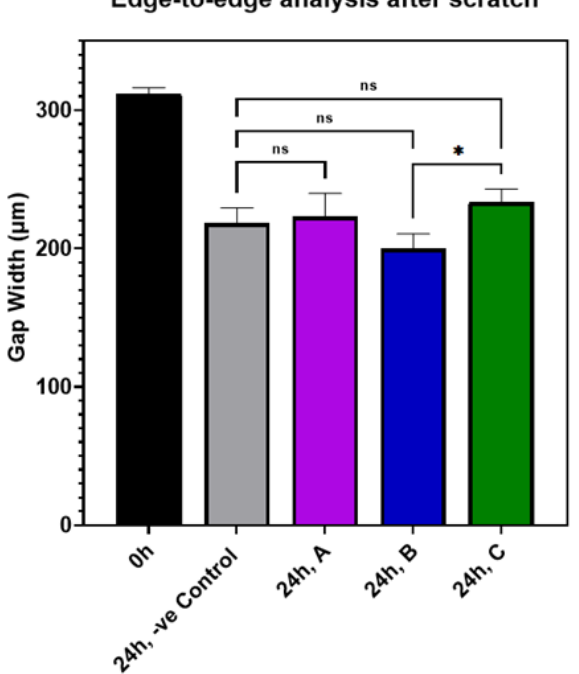
Figure 9. Bar graph comparing the edge-to-edge analysis in an in vitro wound scratch assay after 24 h of incubation of ARPE-19 cells exposed to AuQD samples prepared at different ablation times: sample A (7.8 nm), sample B (8.7 nm), and sample C (11.6 nm), compared to the control cells. Sig-